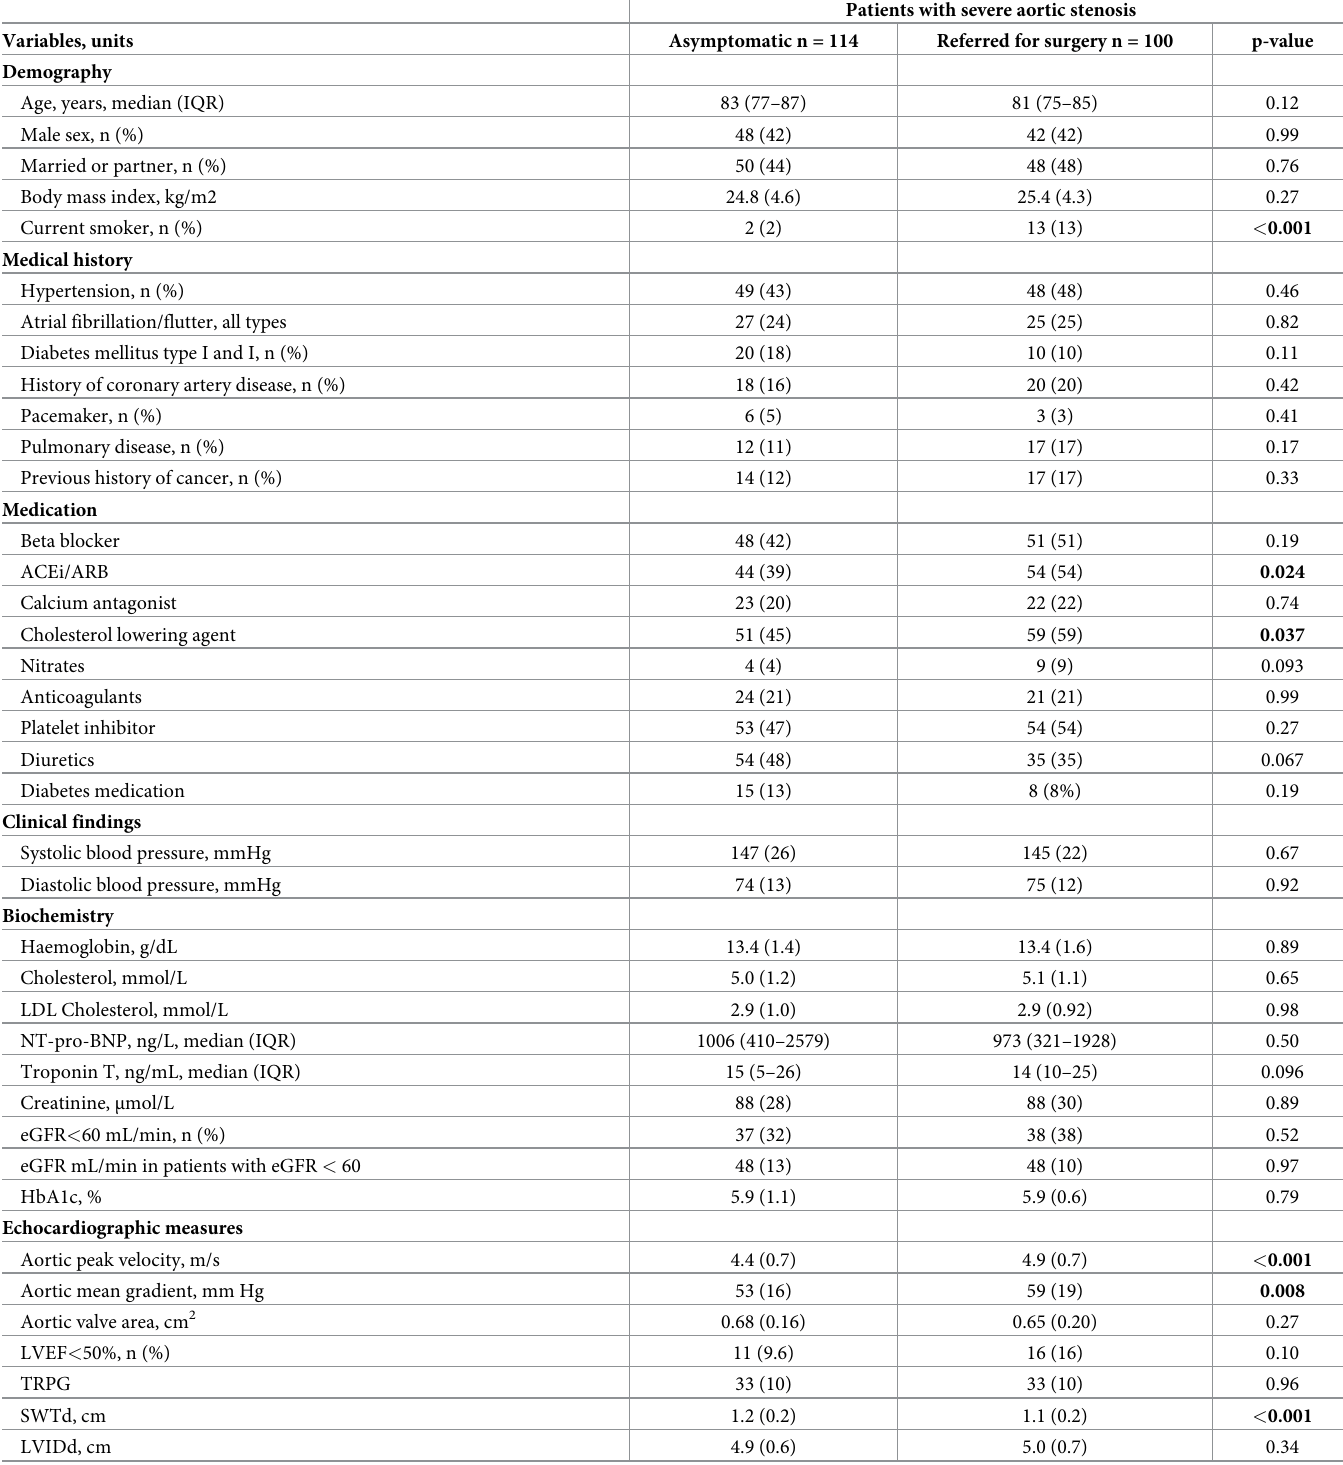
Table 1. Baseline characteristics of patients with asymptomatic severe aortic stenosis compared to 100 age and gender matched patients with severe aortic stenosis referred for aortic valve